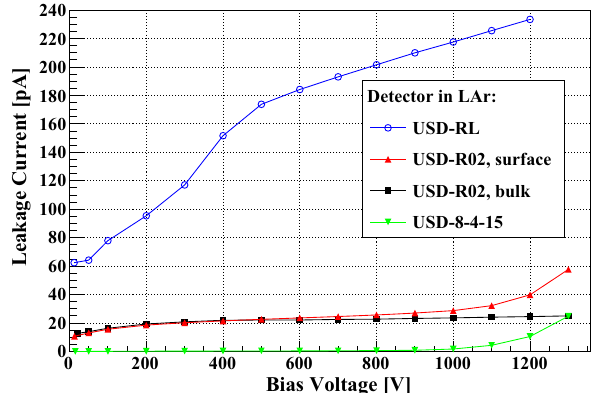
Fig. 17 Highest leakage currents of the three detectors measured in LAr